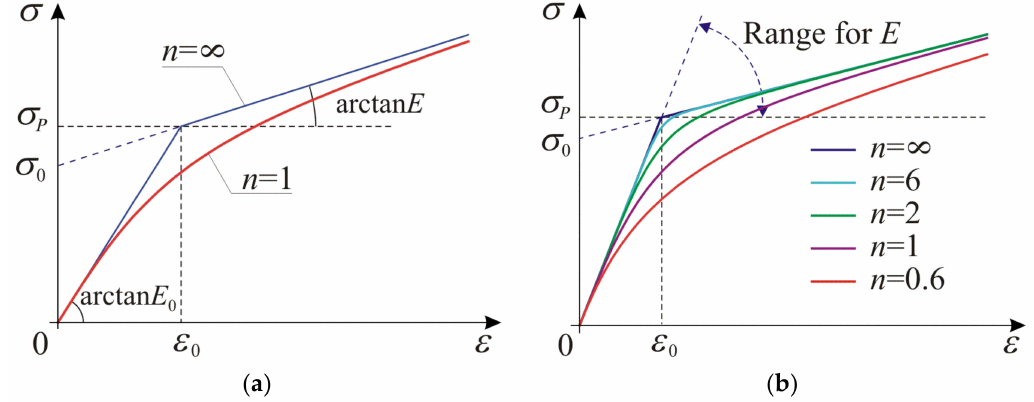
Figure 3. ( a ) Stress–strain curves according to the one-dimensional model of elastic material for n = 1 and n → ∞ (piecewise linear). Graphical interpretation of material parameters: E 0 , E , ε 0 , σ 0 and σ P . ( b ) Stress–strain curves for several values of n with possible range for the hardening modulus E